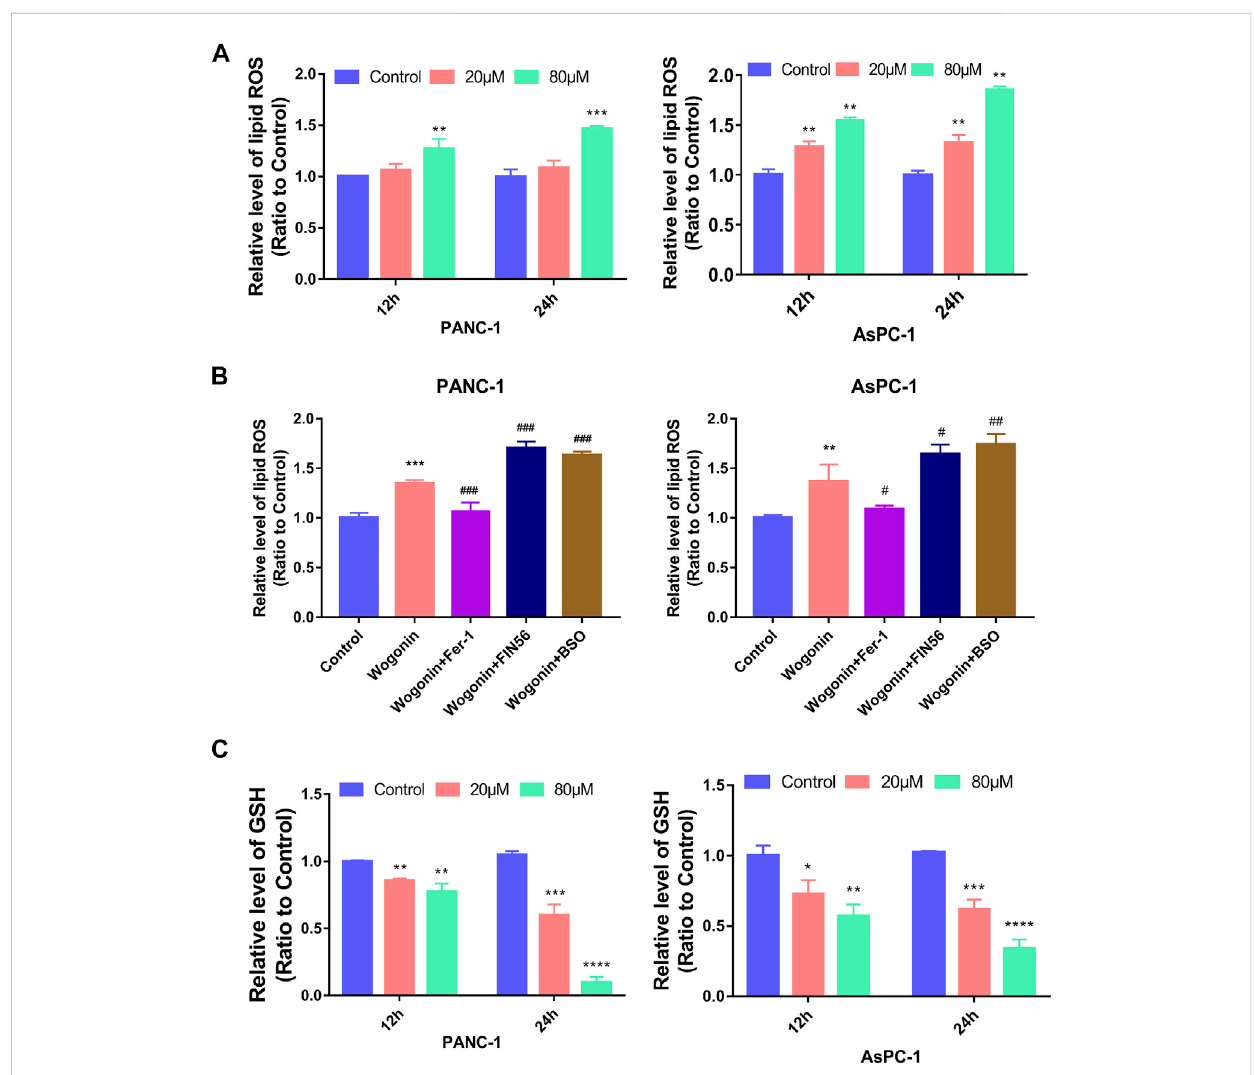
FIGURE 4 Wogonin induced lipid peroxidation and GSH changes in pancreatic cancer cells. (A) Wogonin induced accumulation of lipid peroxidation in pancreatic cancer cells in a dosage- and time-dependent manner. (B) The upregulation of lipid peroxidation caused by wogonin was prevented by pretreatment with Fer-1, but was promoted by BSO or FIN56. (C) Wogonin reduces the level of GSH in pancreatic cancer cells in a dosage- and time- dependent manner. * p < 0.05 versus control group; **: p < 0.01 versus control group; ***: p < 0.001 versus control group; ****: p < 0.0001